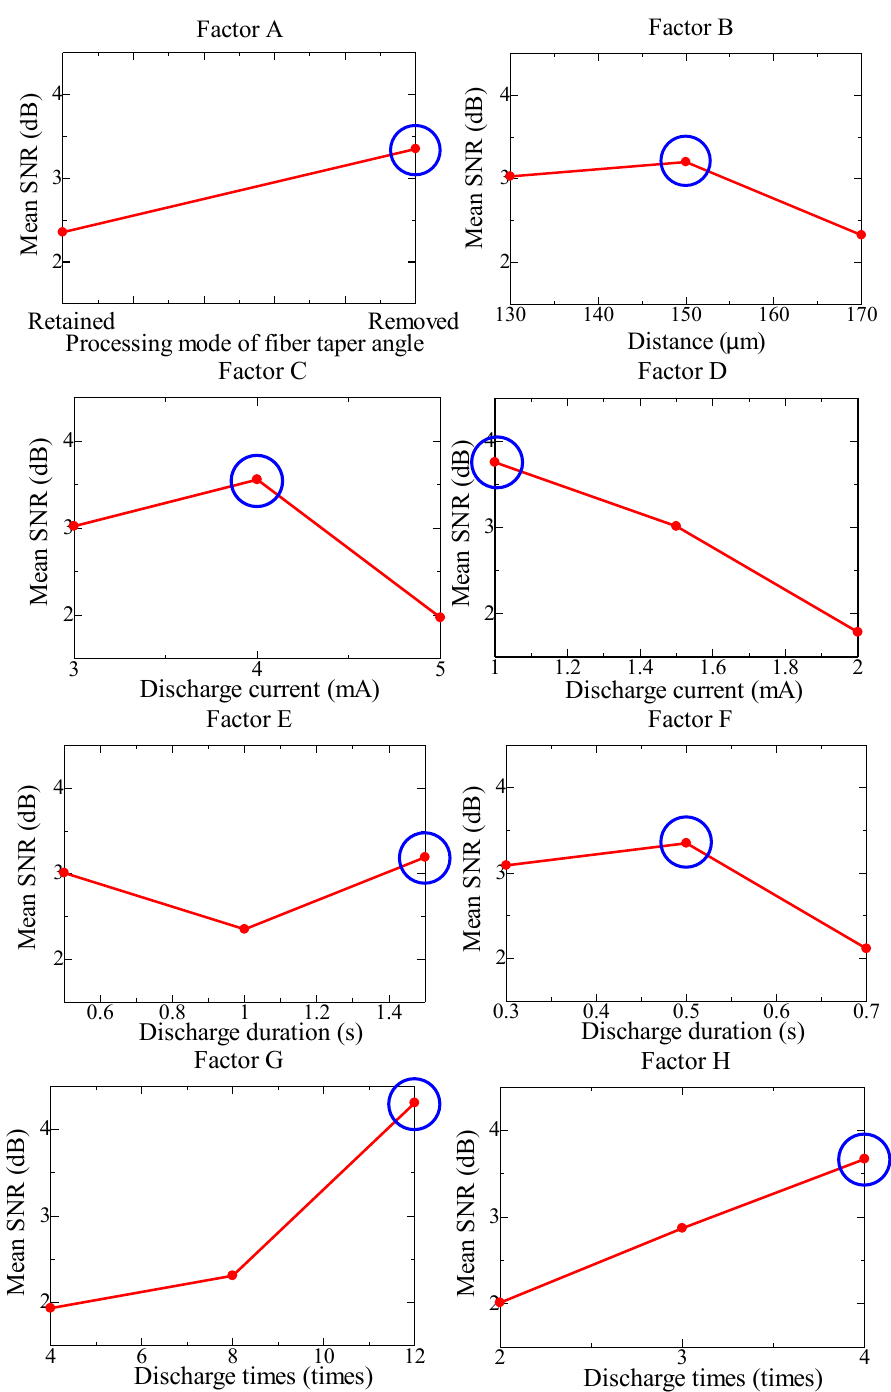
Figure 4. The mean SNR at different levels of process factors for 2D roundness